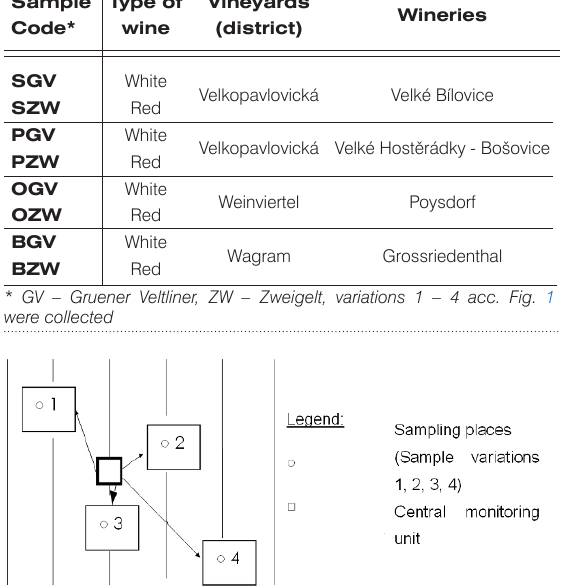
Table 1. List of analysed wine samples Sample